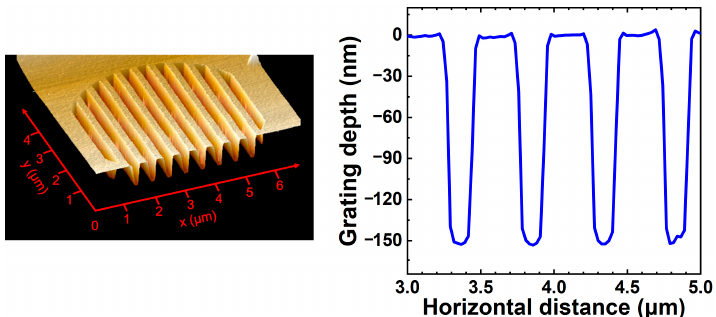
Figure 3. Atomic force microscopy (AFM) image and line-scan profile for a typical surface